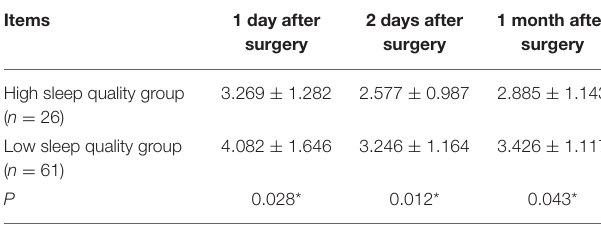
TABLE 2 | Pain scores of patients in two groups at different time points after surgery ( n = 87).